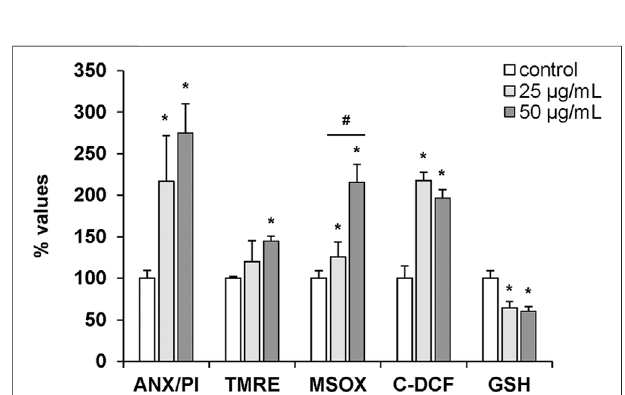
FIGURE 8 | mitochondrial superoxide (O 2 − ) production; (C) CM-H2DCFDA (C-DCF), for generation of intracellular H 2 O 2 . Rows correspond to different concentrations of the OlyA6/PlyB mixture (0, 10 and 25 μ g/ml). Columns show: (a) bright fi eld, (b) fl uorescence signals of TMRE, MitoSOX and C-DCF (c) merged channels. Scale bar: 25 μ m.